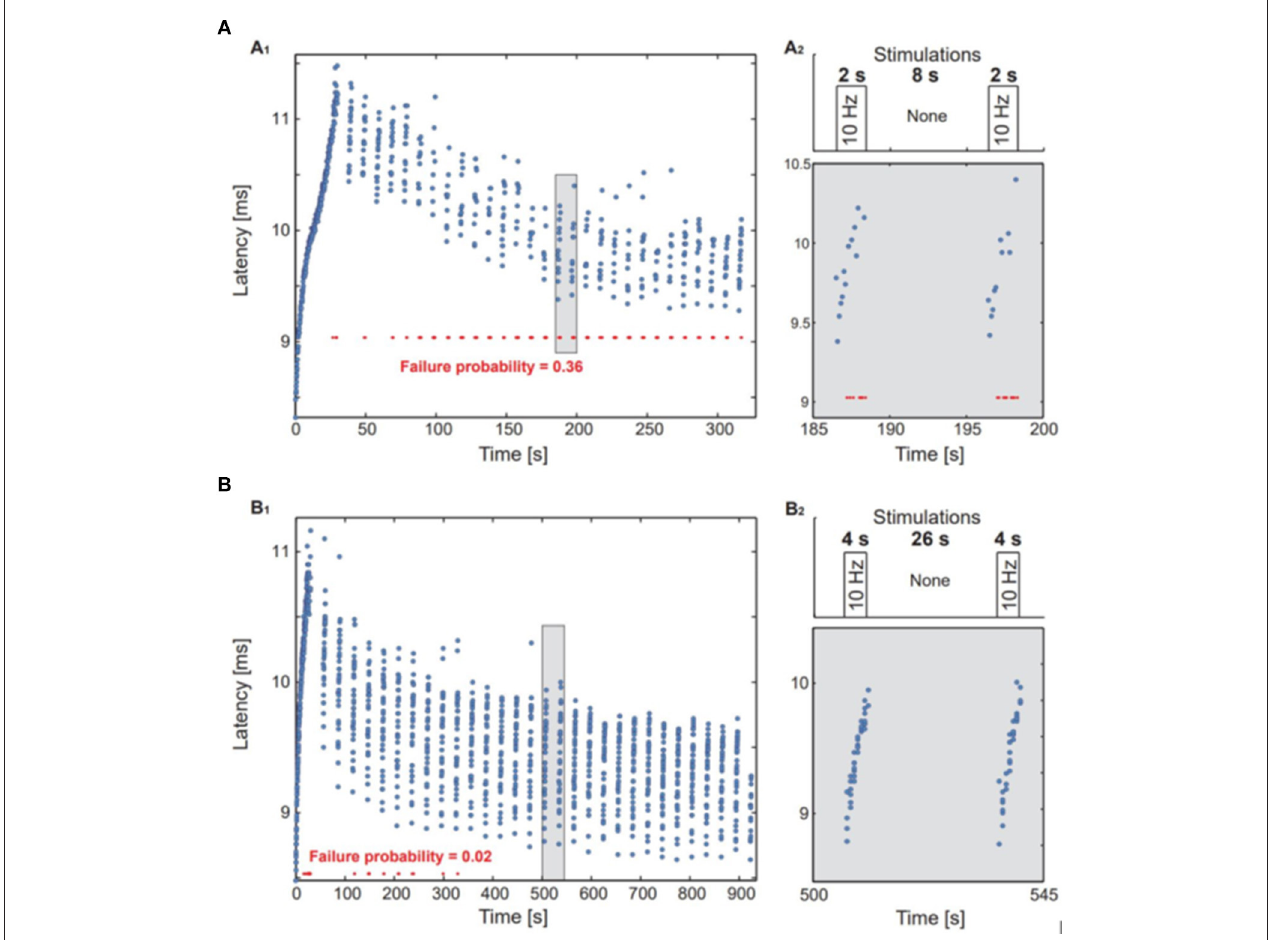
FIGURE 2 | In vitro experiments in single neurons. A neuron with an fc = 1.3Hz was stimulated above the threshold using the stimulation timings of protocols A and B. (A1,B1) The neuronal response latency was measured for each response, response failures are represented by red dots. (A2 , B2) upper panel: an illustration of the stimulation protocol. Lower panel: a zoom-in of the marked area at (A1 , B1) .